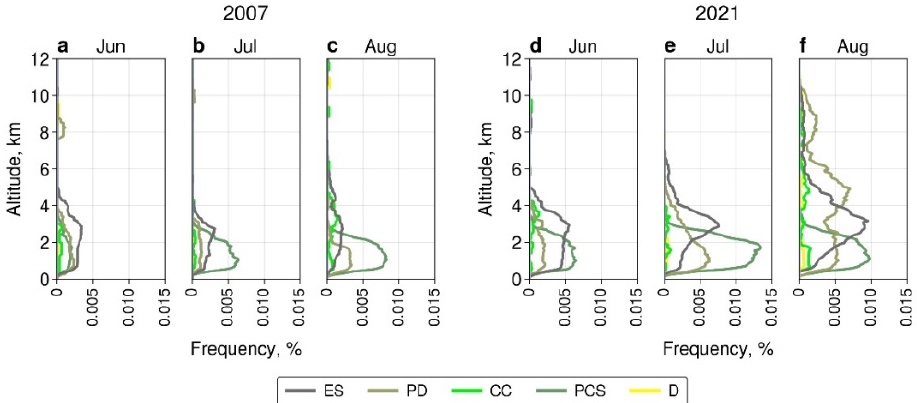
Figure 9. Occurrence frequency profile of each CALIOP aerosol type for ( a ) June, ( b ) July, ( c ) August 2007, and ( d ) June, ( e ) July, and ( f ) August 2021. Aerosol types: ES—elevated smoke, PD—polluted dust, CC—clean continental, PCS—polluted continental/smoke, D—dust.